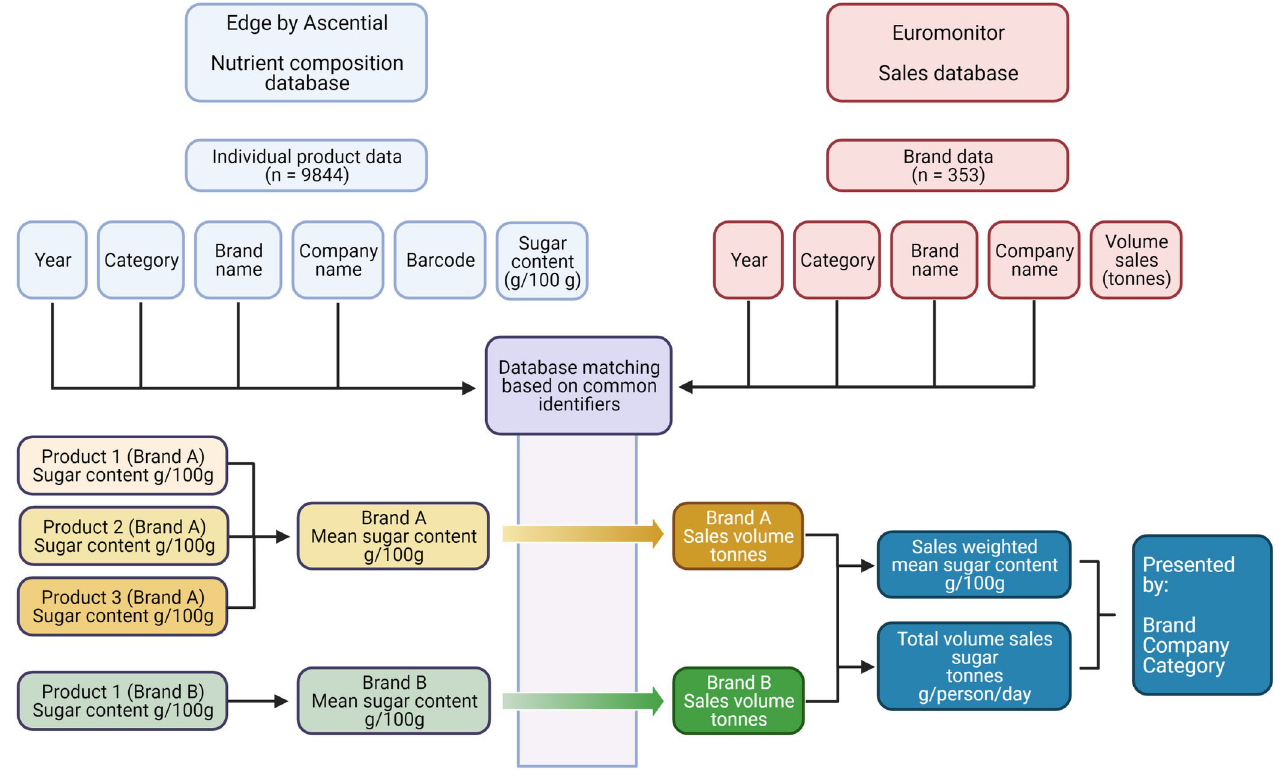
Fig 1. AU : InFig 1 ; topmostEuromonitorbox ; databaseismisspelled : Pleasefixthismisspelling : Whileyouareinthere ; IrecommendchangingNutritioncompositiontoNutrientcompositioninthetopmostEdgebyAscentialbox ; tomatchthemaintext : Data and analysis flow chart.